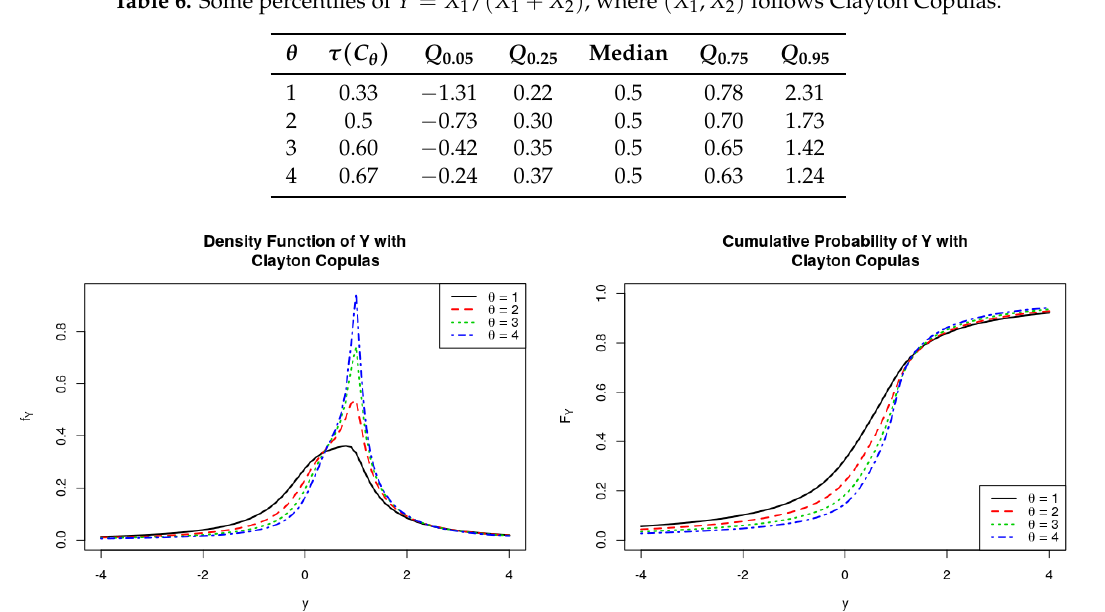
Figure 5. PDFs and CDFs of the ratio Y = X 1